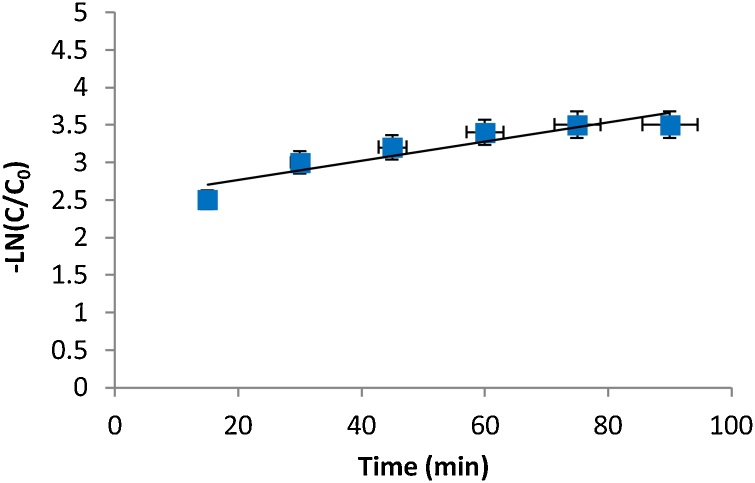
Pseudo-first-order plot for the degradation of aniline by US/H2O2.